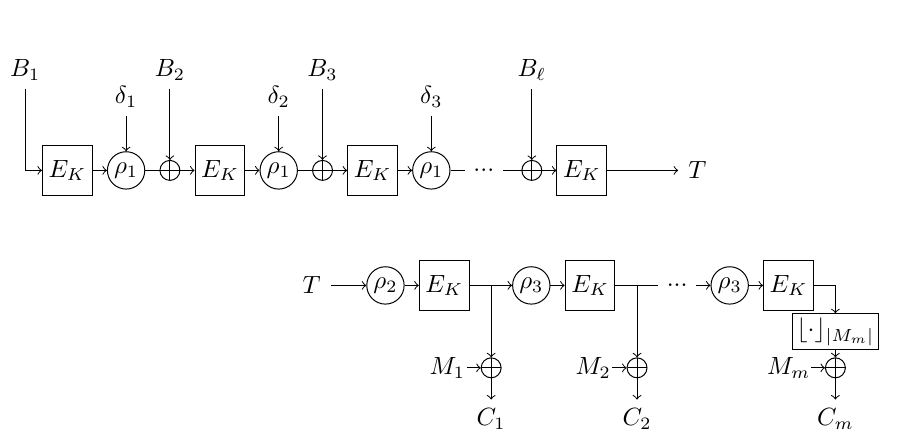
Figure 4: The authenticated encryption scheme ANYDAE (Section 5.1), where for